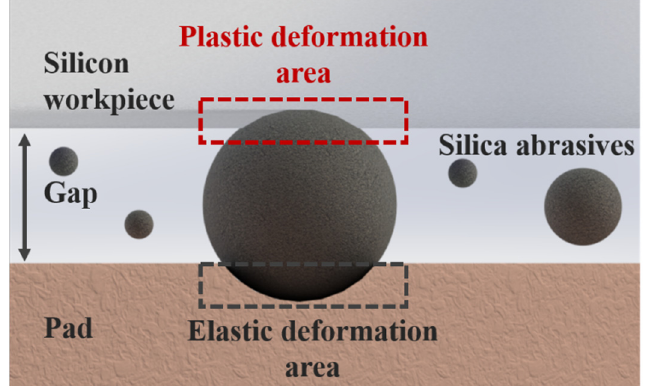
Figure 1. Profile of free abrasives entering the gap between the pad and silicon workpiece. Abrasives, such as silica, under a dynamic load generate recoverable elastic deformation on the pad and permanent plastic deformation on the ductile silicon workpiece. Continuous plastic deformation creates scratches on the workpiece surface.